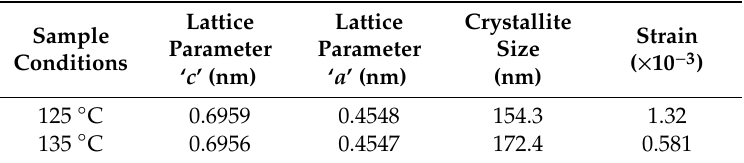
Table 1. Summary of X-ray di ff raction information, including lattice parameters (constants), crystallite sizes, and strain of the two PbI 2 films deposited at di ff erent substrate